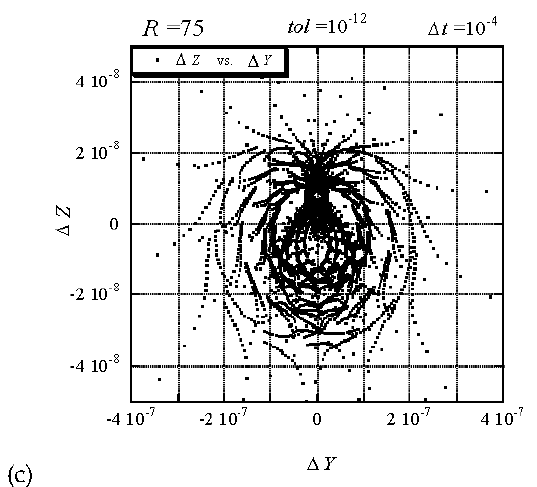
Figure 11. Trajectory of differences between the computational (Adomian decomposition) and numerical (Runge-Kutta) solutions corresponding to ∆ t = 10 − 4 in the computational solution, tol = 10 − 12 in the numerical solution, and R = 75. ( a ) projection of trajectory’s data points on the plane ∆ Z = 0; ( b ) projection of trajectory’s data points on the plane ∆ Y = 0; ( c ) projection of trajectory’s data points on the plane ∆ X = 0. (Data points are not connected) [11]. (Reproduced with permission from Peter Vadasz, Shmuel Olek, International Journal of Heat and Mass Transfer; published by Elsevier,